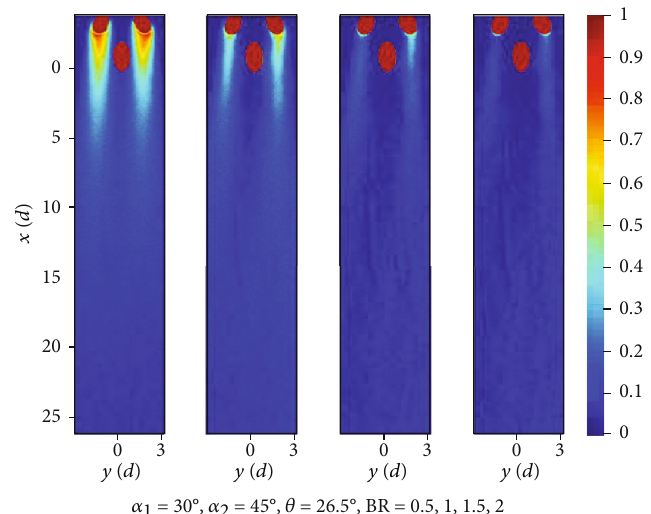
Figure 16: Film cooling e ff ectiveness distributions downstream of the branched holes, α